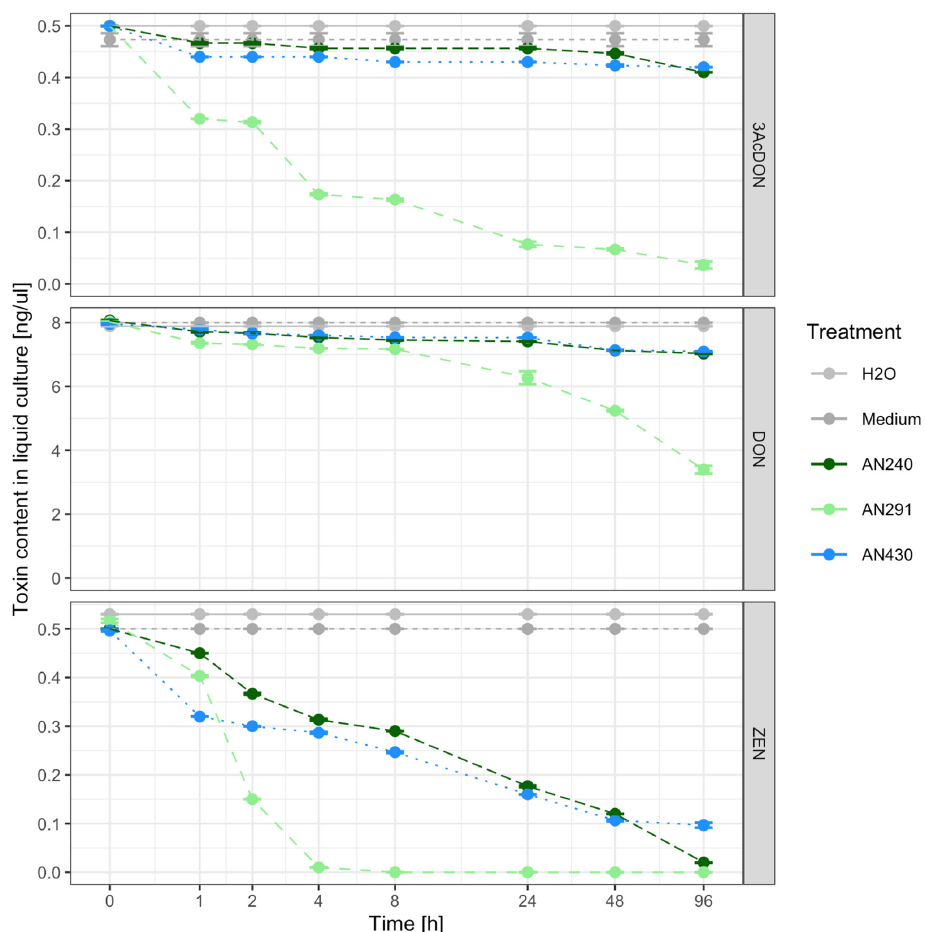
Figure 6. Timeline plot. Toxin content in liquid solution, depending on time (1, 2, 4, 8, 24, 48, 96 hpi) and treatment (H 2 O, medium, AN240, AN291, AN430).